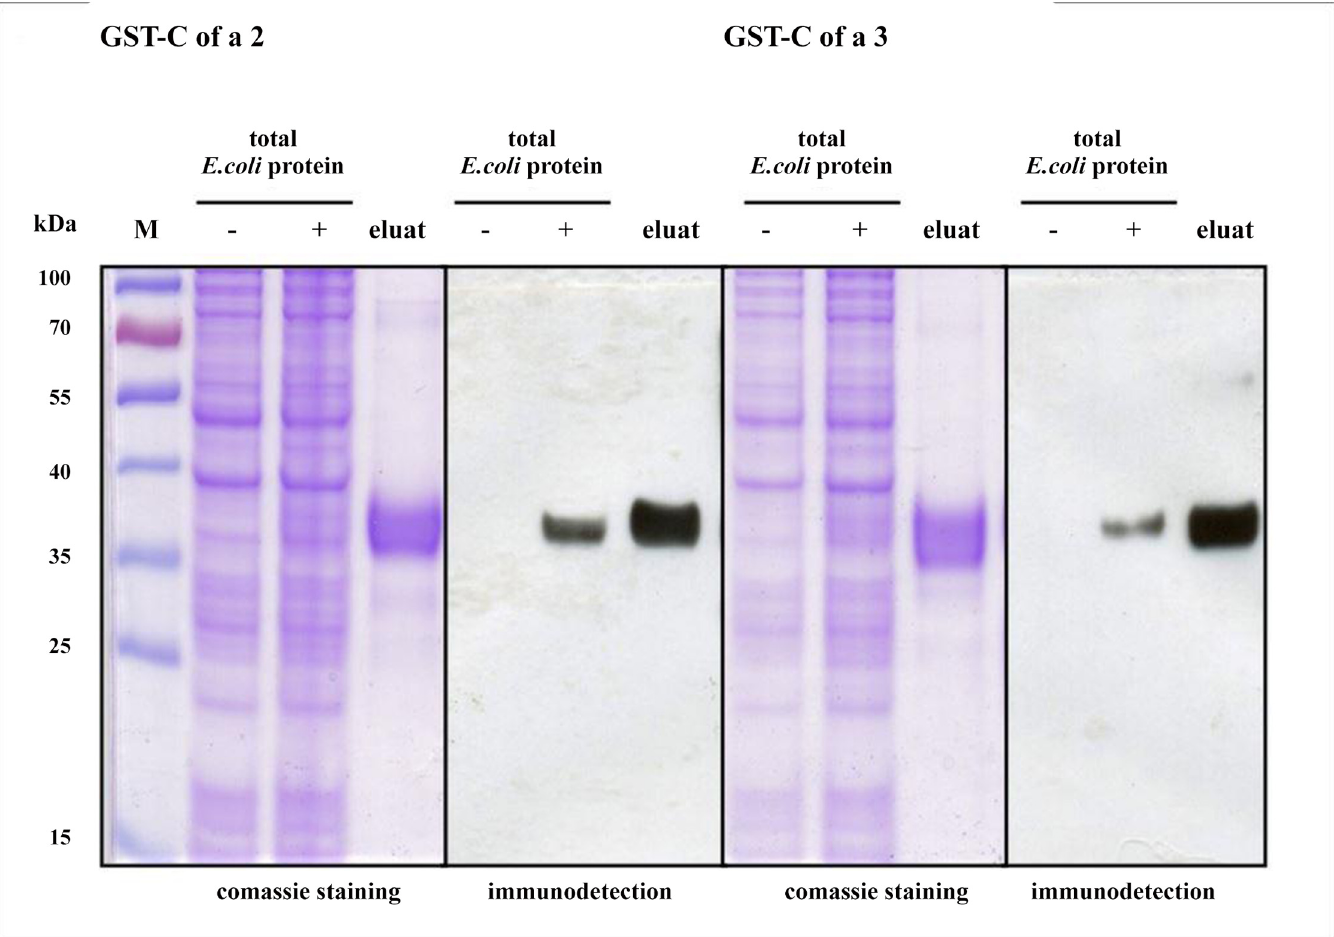
Fig 4. Purification and immunodetection of rCof a 2 and rCof a 3. Purification of E . coli -expressed rCof a 2 and rCof a 3 under native conditions. Proteins recovered by GST affinity cromatography were separated by SDS-PAGE (eluat). Total E . coli protein fractions before and after IPTG supplement are indicated by − and +; M: molecular wight marker. The first gel stained with coomassie brilliant blue, the second for immunodetection with anti His-Ab. Both gels ran together at same conditions.